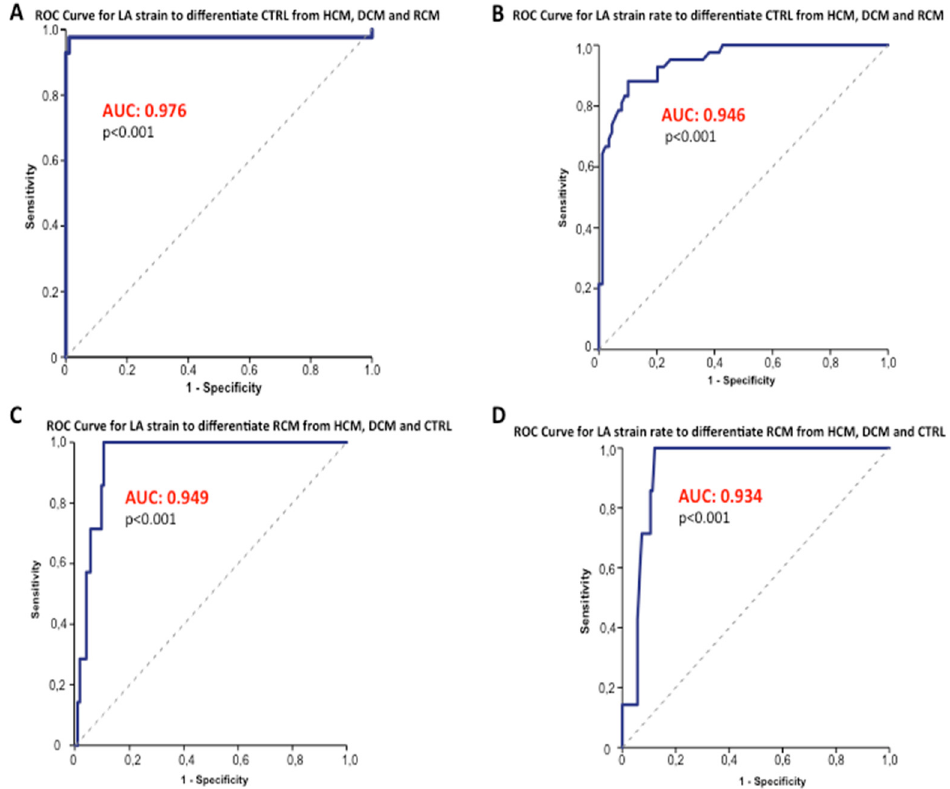
Figure 4. LA strain and strain rate Receiver-Operating Characteristic Curves. The ROC Curve showed optimal capability for LA strain and strain rate ( A , B ) to discriminate healthy children with normal diastolic function from patients with paediatric cardiomyopathies (LA strain AUC = 0.976, p < 0.001; LA strain rate AUC = 0.946, p < 0.001). Panel ( C , D ) shows ROC Curves (LA strain AUC = 0.949, p < 0.001; LA strain rate AUC = 0.934, p < 0.001) which differentiate RCM from the other three study groups (HCM, DCM and CTRL). ROC = receiver-operating characteristic. AUC: area under the curve. CTRL: normal controls. HCM: Hypertrophic Cardiomyopathy. DCM: Dilated Cardiomyopathy. RCM: Restrictive Cardiomyopathy. LA: Left